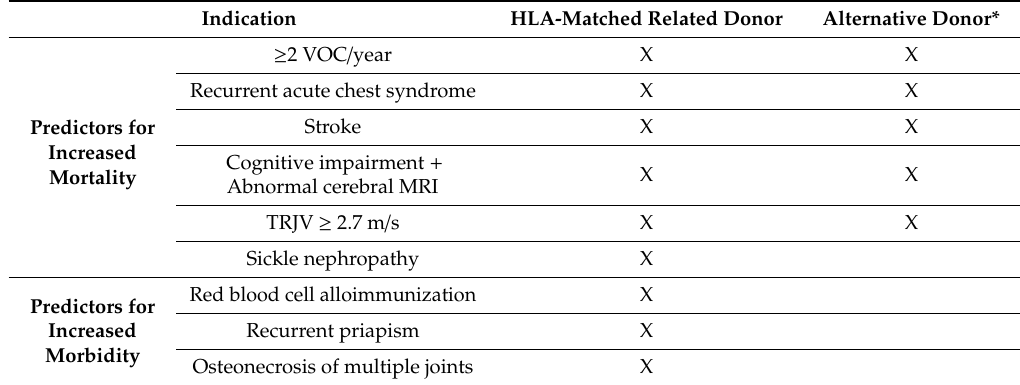
Table 1. Indications for allogeneic hematopoietic stem cell transplantation in sickle cell disease [34–37].